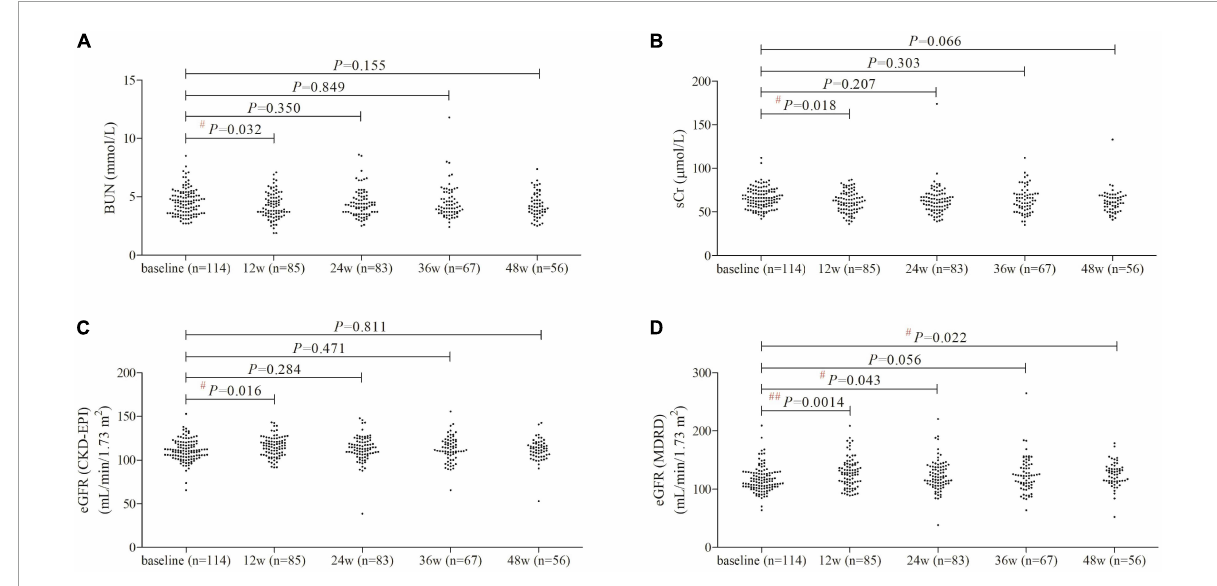
FIGURE1 Evolution of renal function by PEG-IFN α 2b add-on therapy over 48 weeks. (A) Change of BUN. (B) Changes of sCr. (C) Changes of eGFR as calculated by CKD-EPI formula. (D) Changes of eGFR as calculated by MDRD formula. Individual level for each value was shown. Statistical analysis was performed using one-way ANOVA followed by Tukey